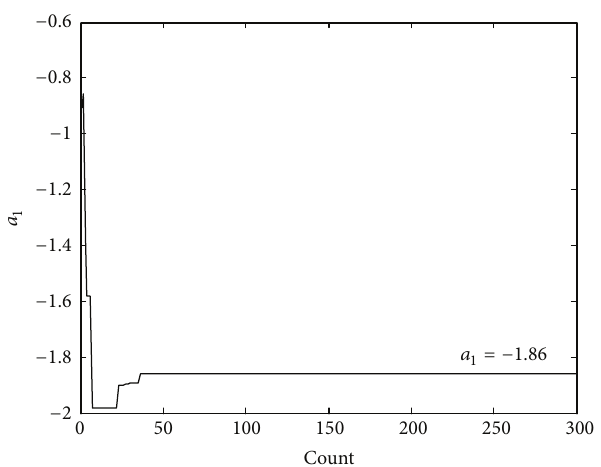
Figure 23: The convergence of 𝑎 0 coefficient.